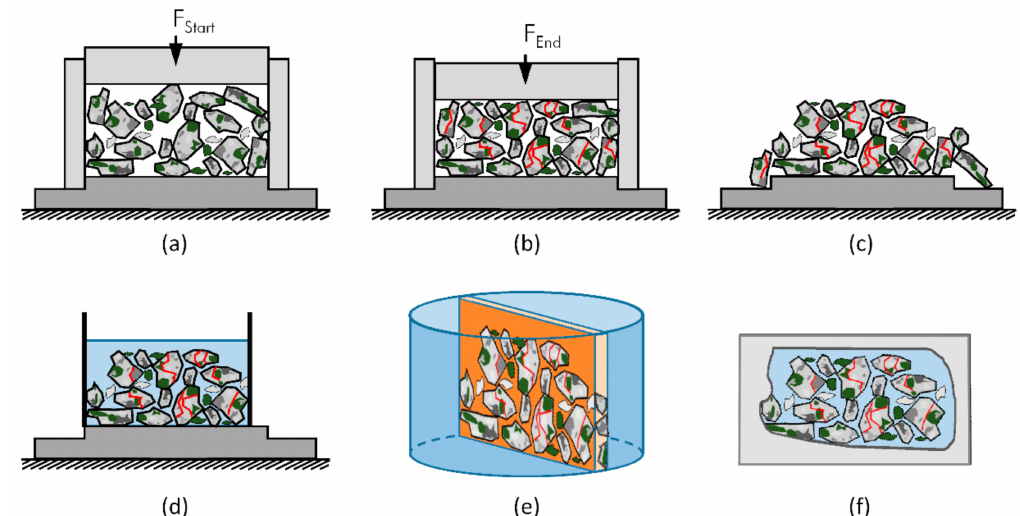
Figure 3. Schema of the experimental procedure and subsequent specimen preparation of the real particle test: ( a ) Setup of the particle bed test; ( b ) Particles break inside the particle bed; ( c ) Press product after removing the pot; ( d ) Press product is grouted with resin; ( e ) Slice of the center of the grouted sample; ( f ) Thin section of the center of the grouted